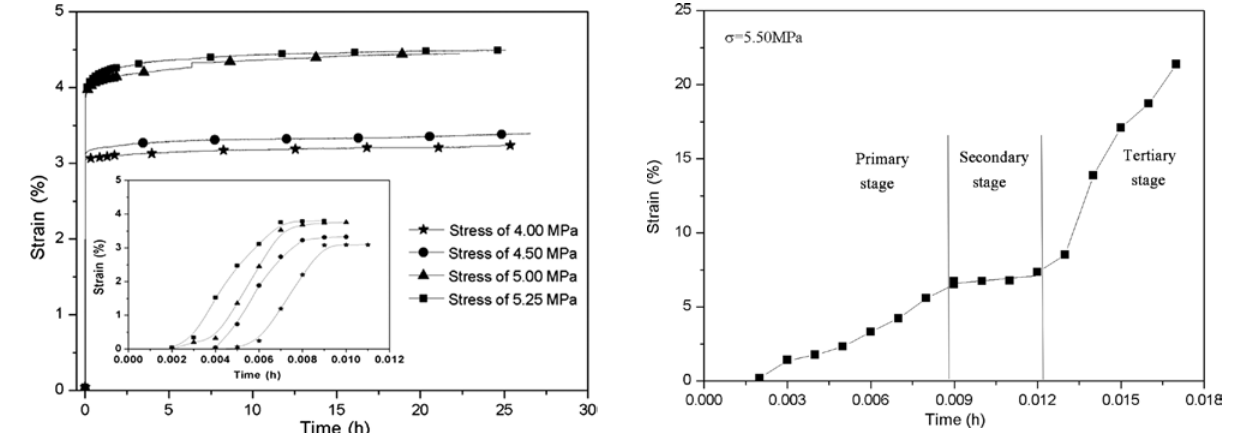
Figure 2: The creep strain-time curves under different stresses.